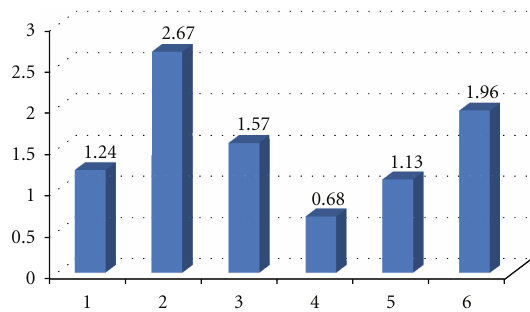
Figure 2: The mean number of surfaces per child with each ICDAS code ( >